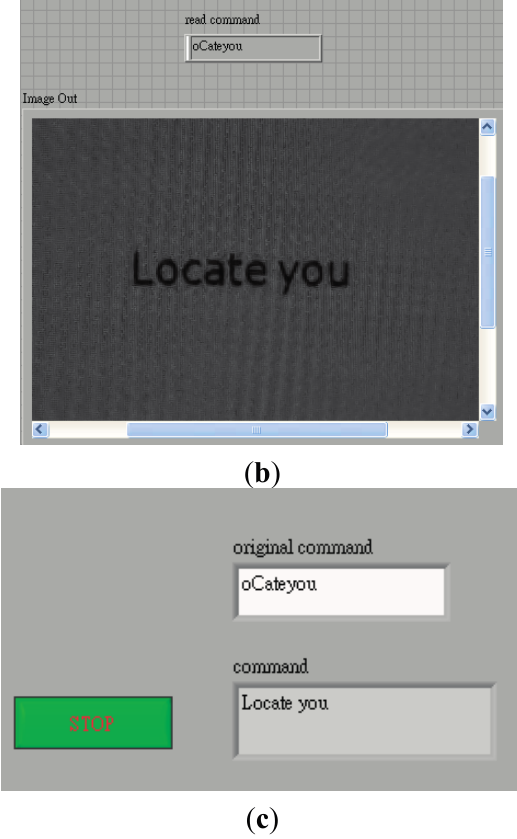
Figure 21. Different conditions corrected by the dictionary process. ( a ) One of the original commands: Locate you (the third letter “c” is recognized as a capital and the letter “a” is missing); ( b ) The other case of the original command: Locate you (missing the first letter, L); ( c ) Corrected by a dictionary